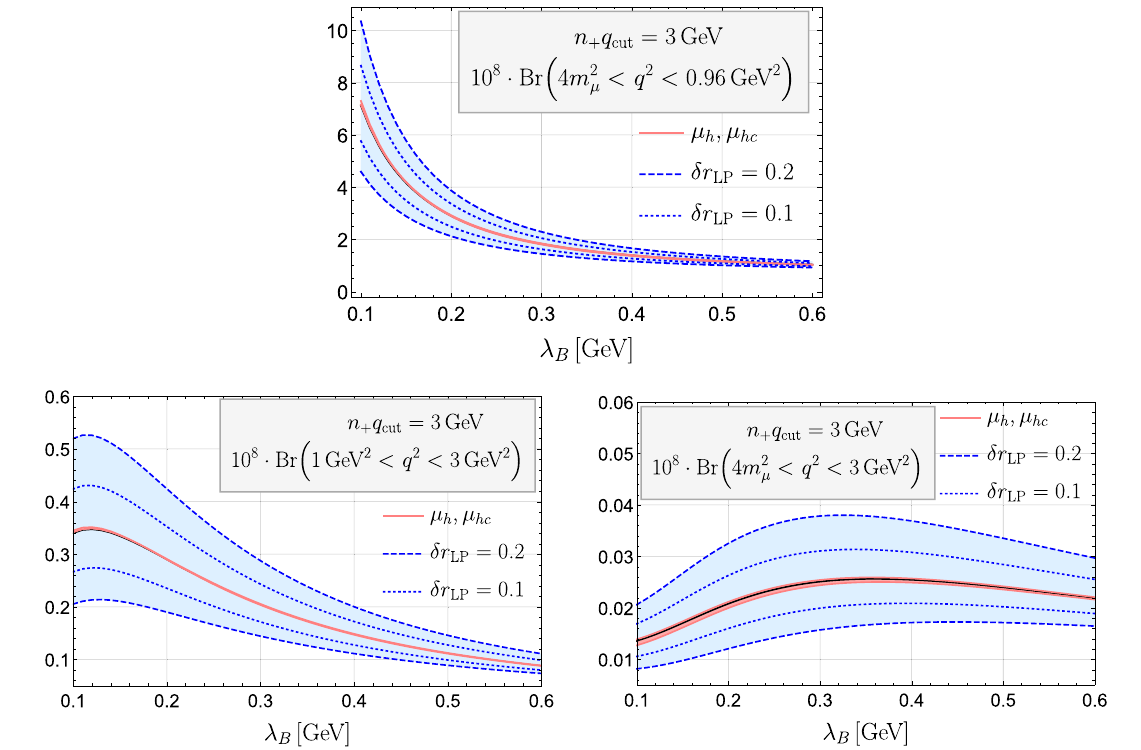
Fig. 7 Branching ratio (in 10 − 8 ) for three different q 2 bins as a function of λ B for the decay mode B − → μ − μ + e − ¯ ν e . We include the variation from μ h , hc and from δ r LP as inner (red) and outer (blue) bands, respectively